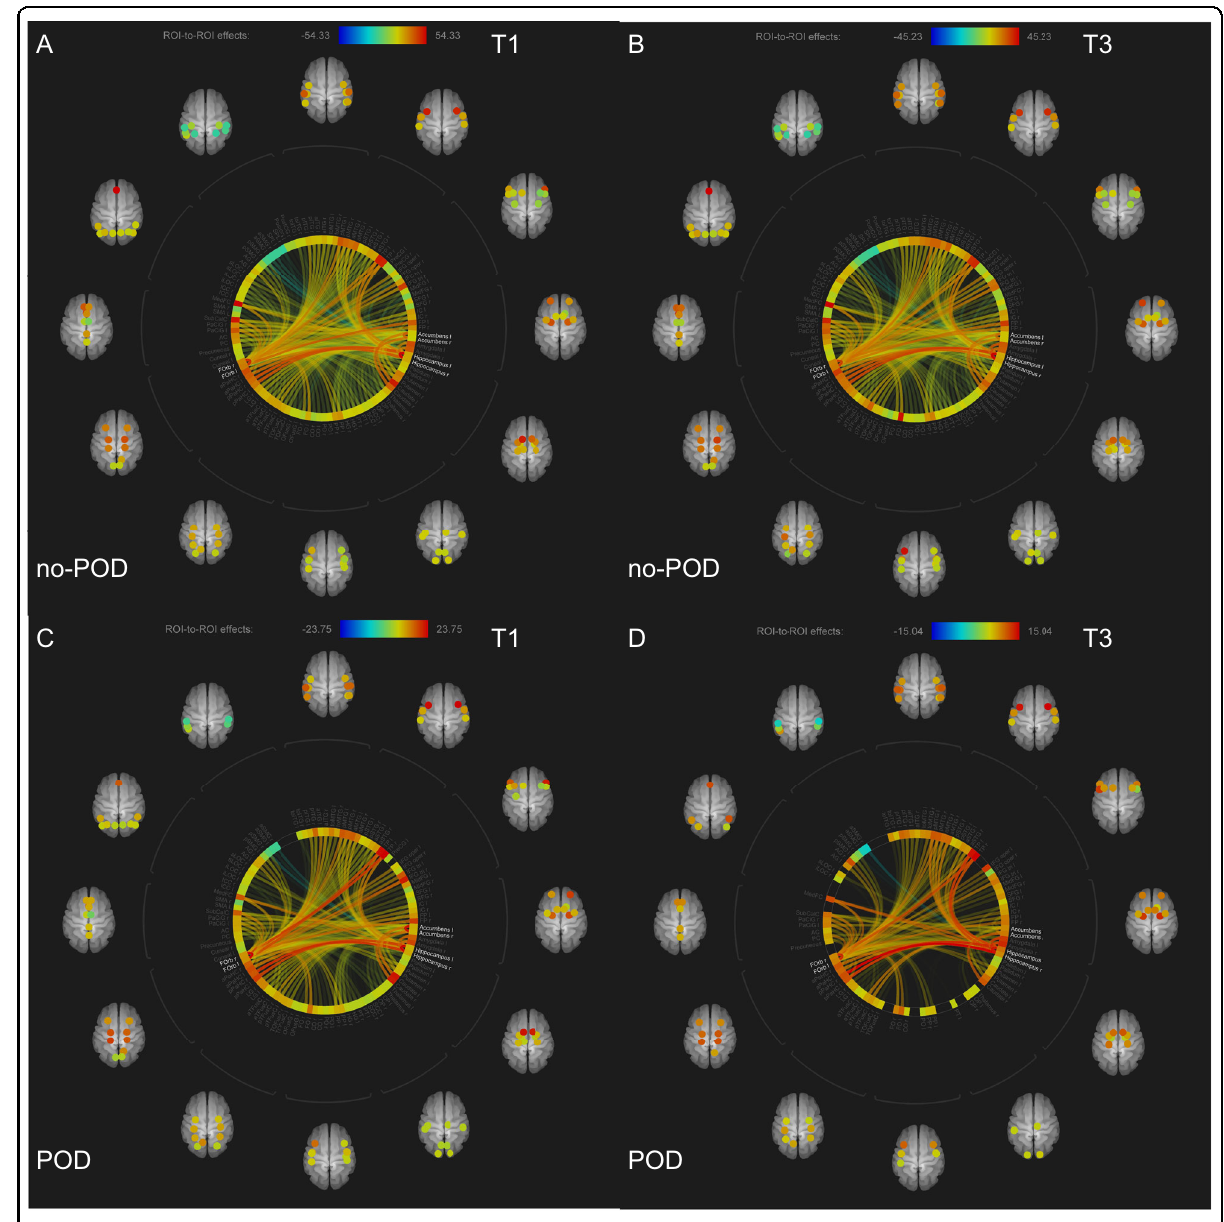
Fig. 1 ROI-to-ROI analysis for each time point (T1, T3) and each group including the three seeds (orbitofrontal cortex, nucleus accumbens, hippocampus). A Preoperative no-POD connectome. B Postoperative no-POD connectome. C Preoperative POD connectome. D Postoperative POD connectome. Note: Different scales for each connectome due to different effect sizes. POD Postoperative